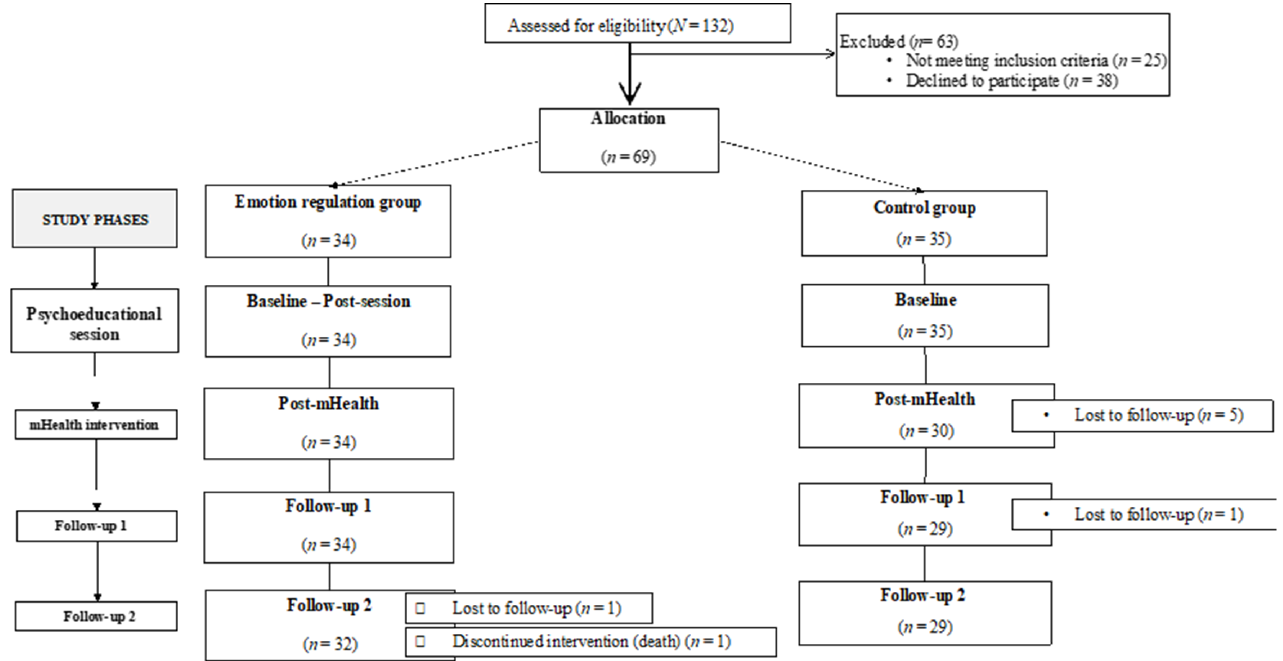
Figure 1. Flow chart of the sample and phases of the study.